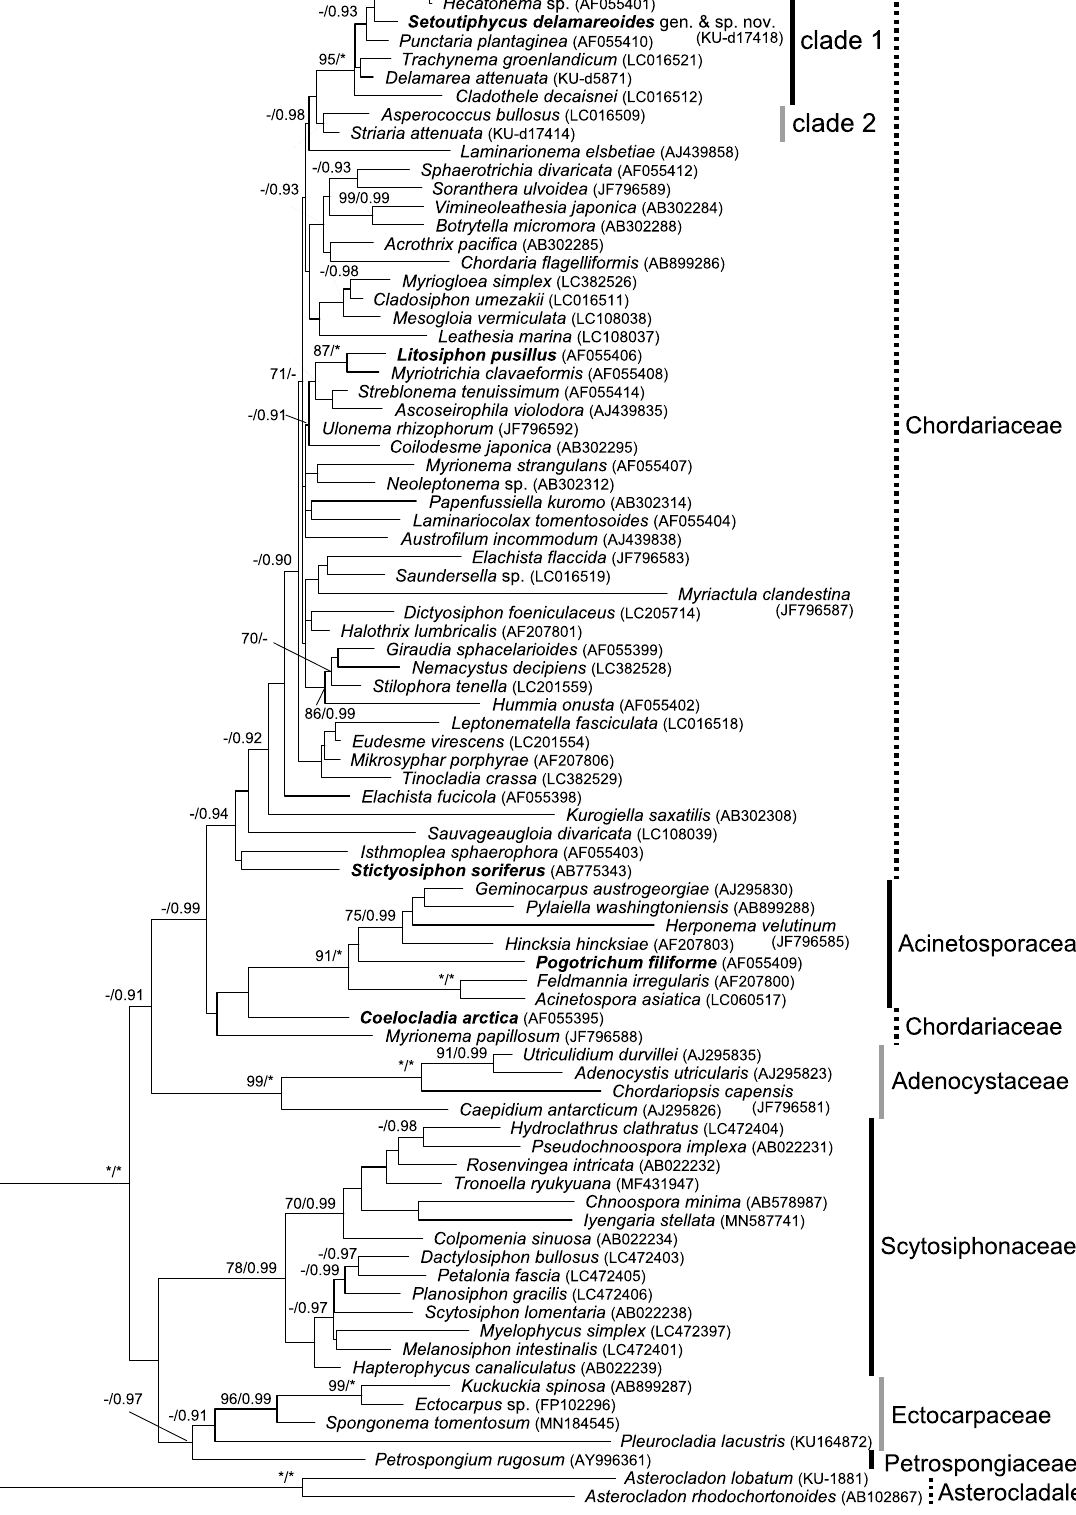
Figure 6. Maximum Likelihood molecular phylogeny of ectocarpacean species including Setoutiphycus delamareoides gen. & sp. nov. based on rbc L genes sequences (1413 bp). Numbers on branches indicate bootstrap values (%) from ML analysis (left) and posterior probabilities from Bayesian analysis (right). Asterisks (*) indicate 100% bootstrap (ML) and 1.00 posterior probability (Bayesian) values. Only bootstrap values > 70% and posterior probabilities > 0.90 are shown. [Artwork by T. Hanyuda and H.